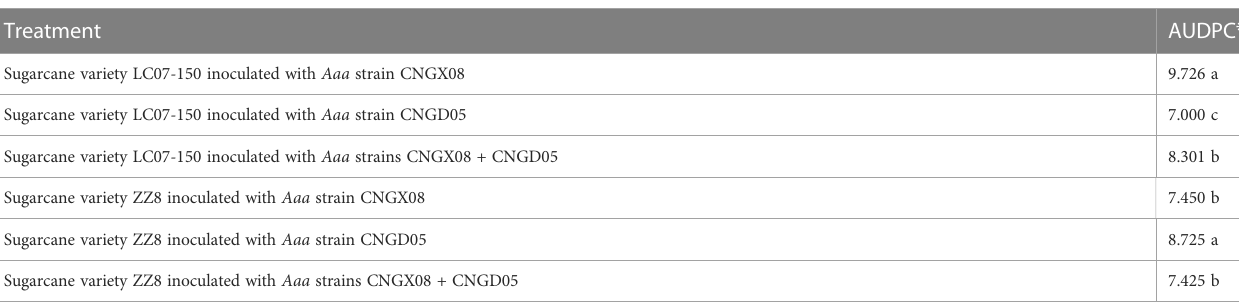
TABLE 2 Analysis of variance of area under disease progress curve (AUDPC*) of two sugarcane varieties inoculated with two strains of Acidovorax avenae subsp. avenae ( Aaa ). Treatment